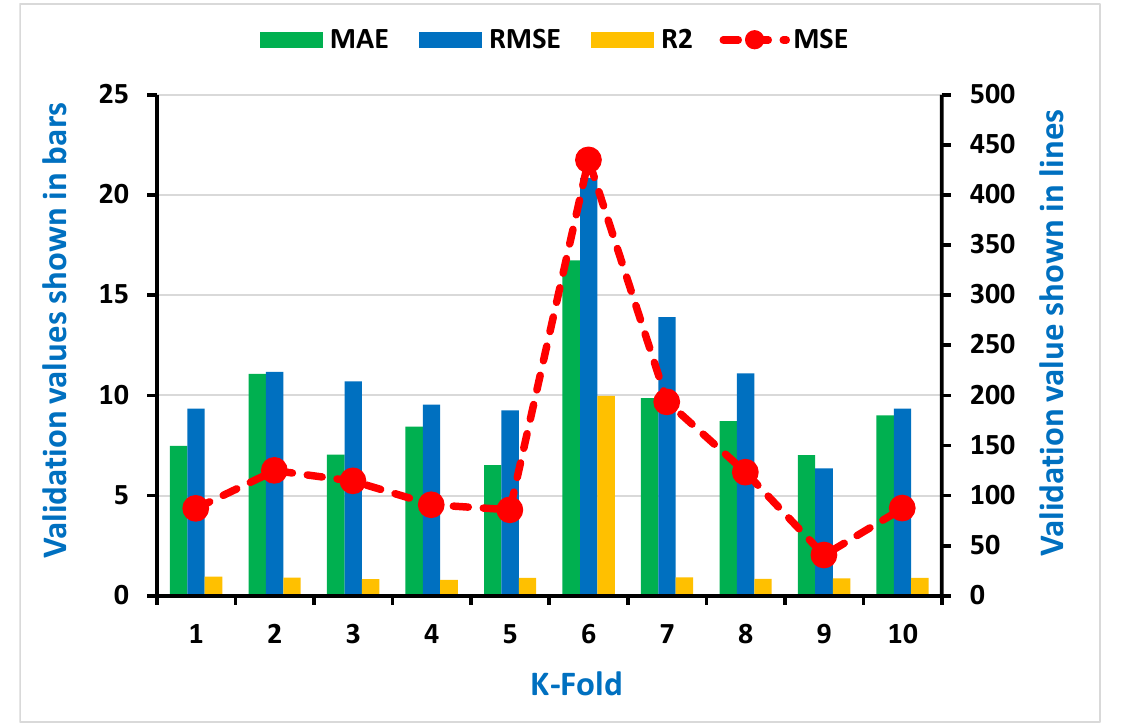
tensile strength.